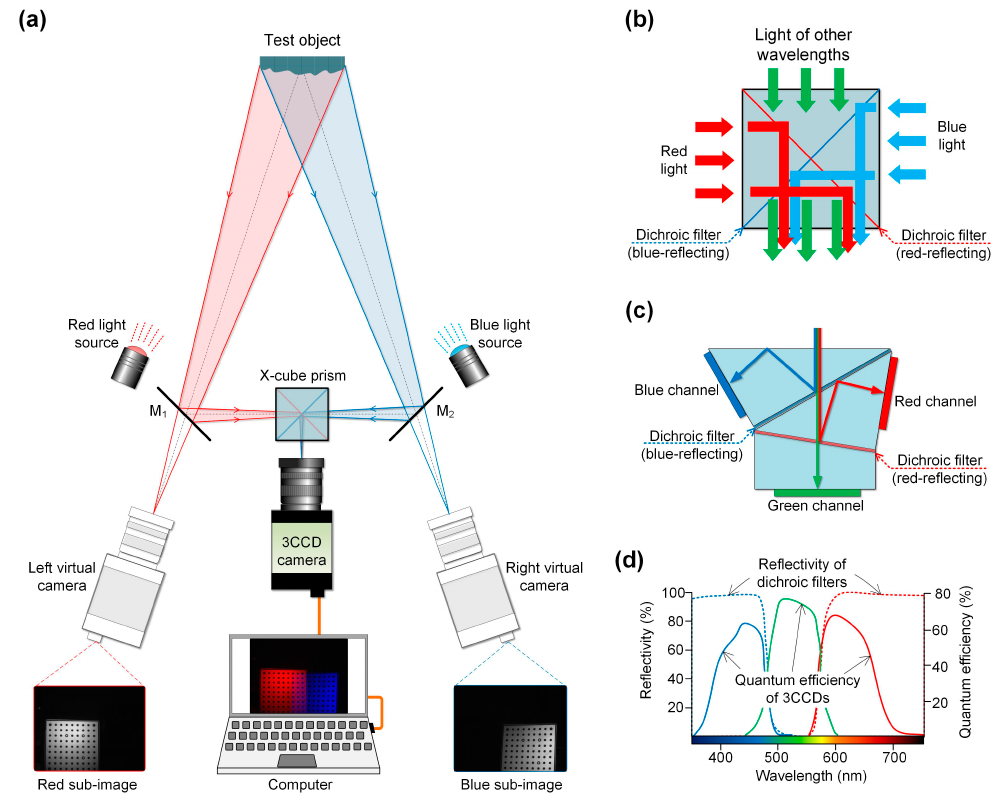
Figure 2. Schematics of ( a ) the proposed X-cube prism assisted single-camera stereo-DIC system, ( b ) an X-cube prism, ( c ) a 3CCD color camera, ( d ) reflectivity of the dichroic filters and quantum e ffi ciency of